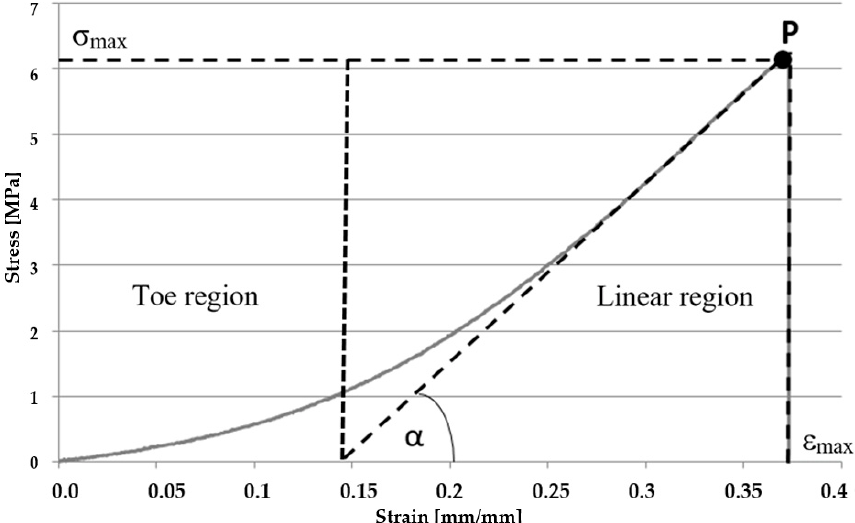
Figure 2. Example of the graph of stress in the strain function for the samples tensile.